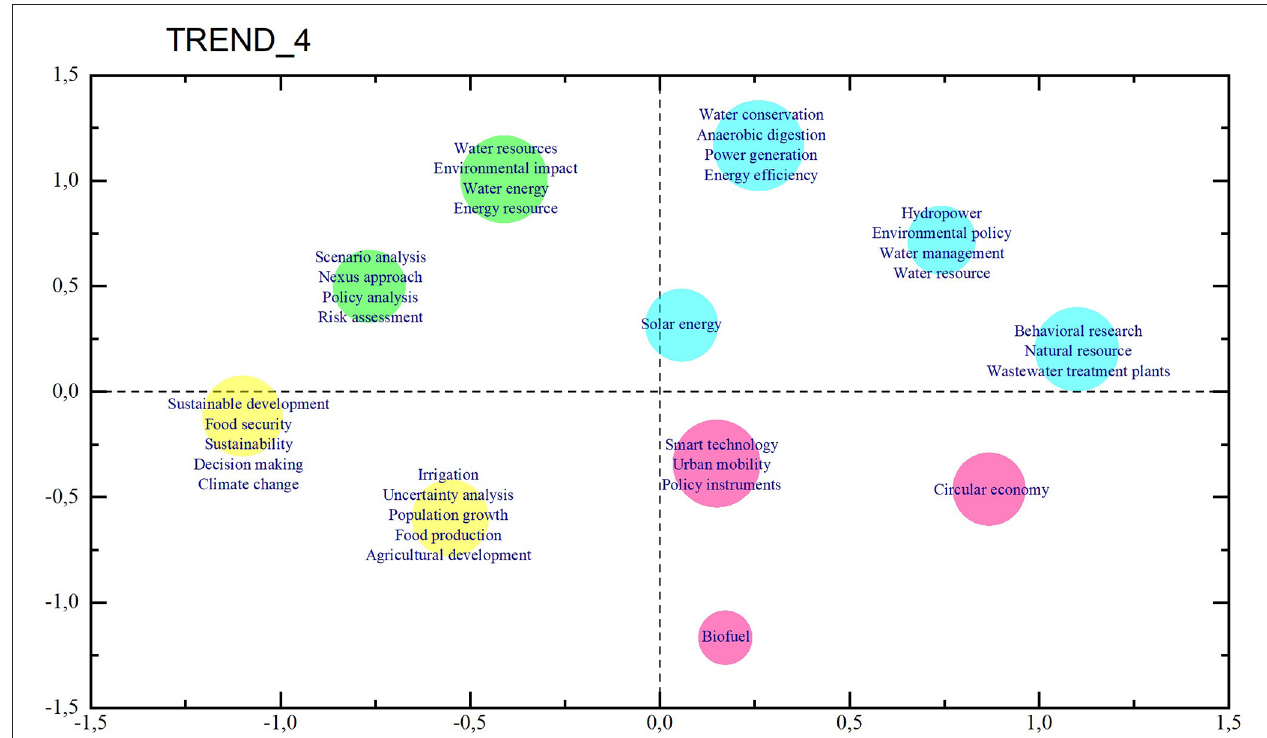
FIGURE 7 | Trend 4 key topics on WEF nexus research in the period